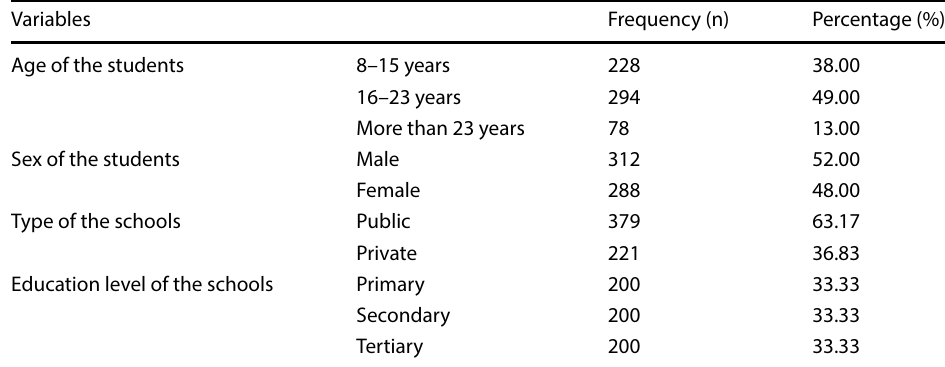
Table 1 Sociodemographic characteristics of the students (n =